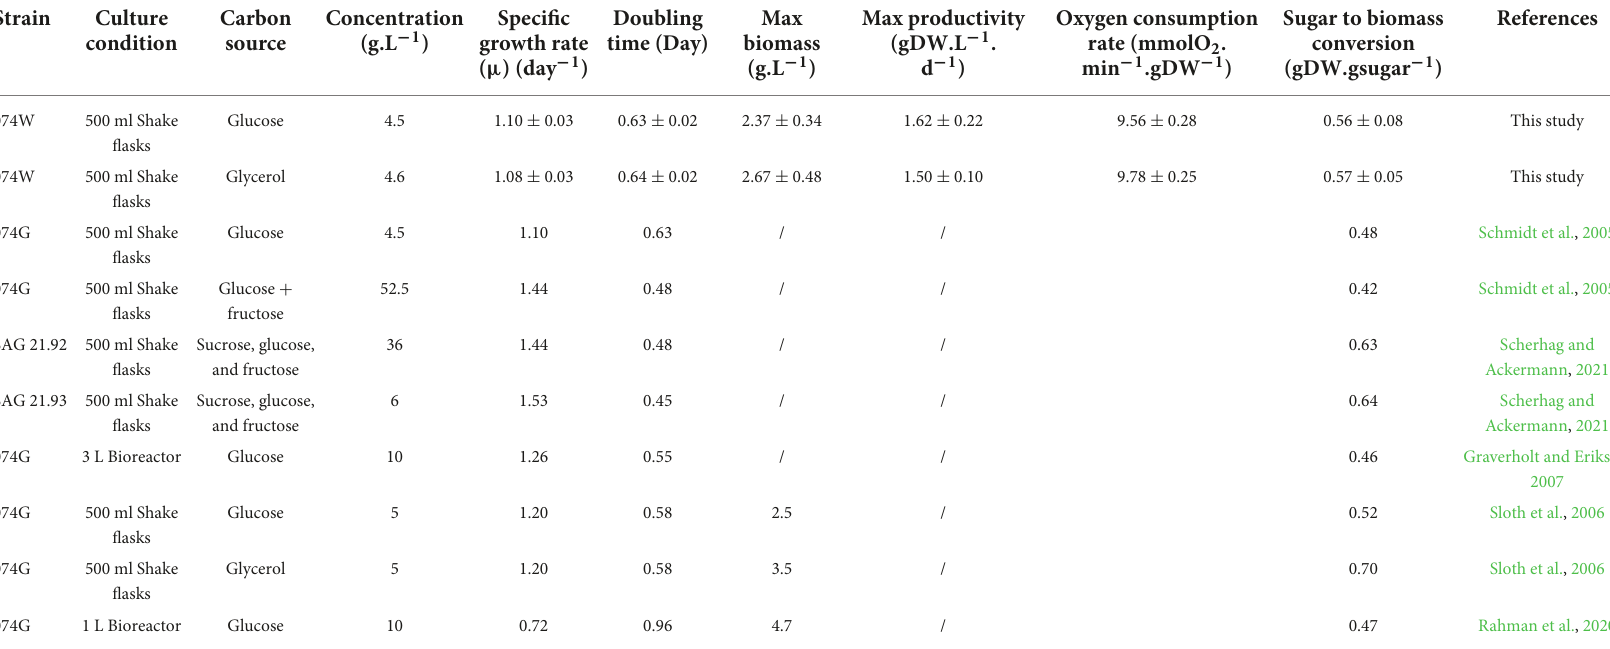
TABLE 1 Comparison of specific growth rate and biomass substrate yield of Galdieria sulphuraria heterotrophic growth on different substrates.